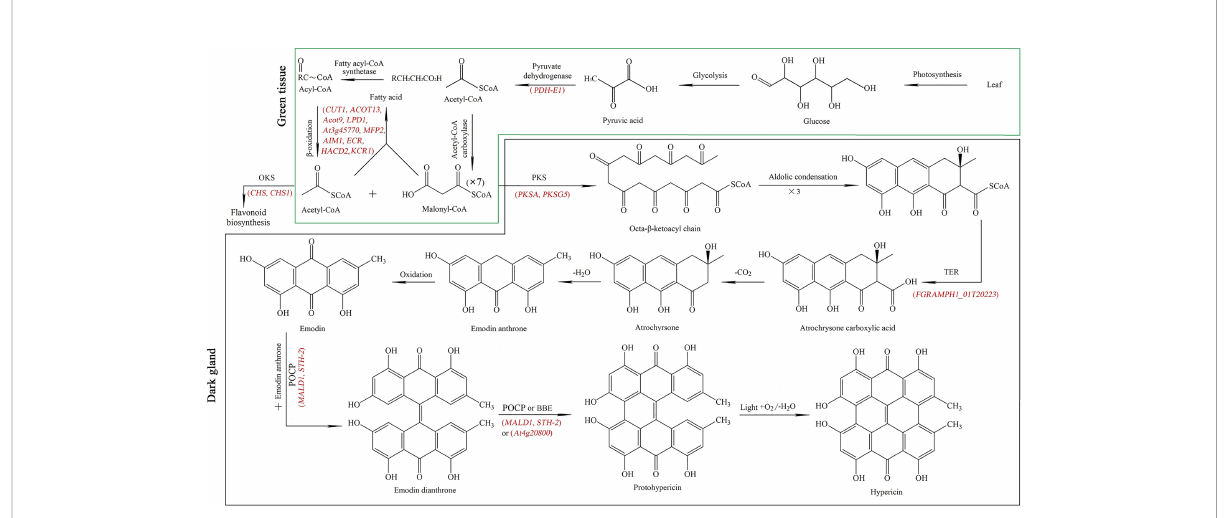
FIGURE 6 Key genes (red color) mapped in the Hyp biosynthetic pathway from glucose to acetyl- and malonyl-CoA in green tissue (green frame), and from acetyl- and malonyl-CoA to Hyp in dark gland (dark frame). PKS: polyketide synthase, OKS: octaketide synthase, TER: thioesterase, POCP: phenoloxidative coupling protein, BBE: berberine bridge enzyme. The Hyp biosynthetic pathway concludes from previous literatures (Zobayed et al., 2006; Rizzo et al., 2019; Rizzo et al., 2020; Su et al., 2021).